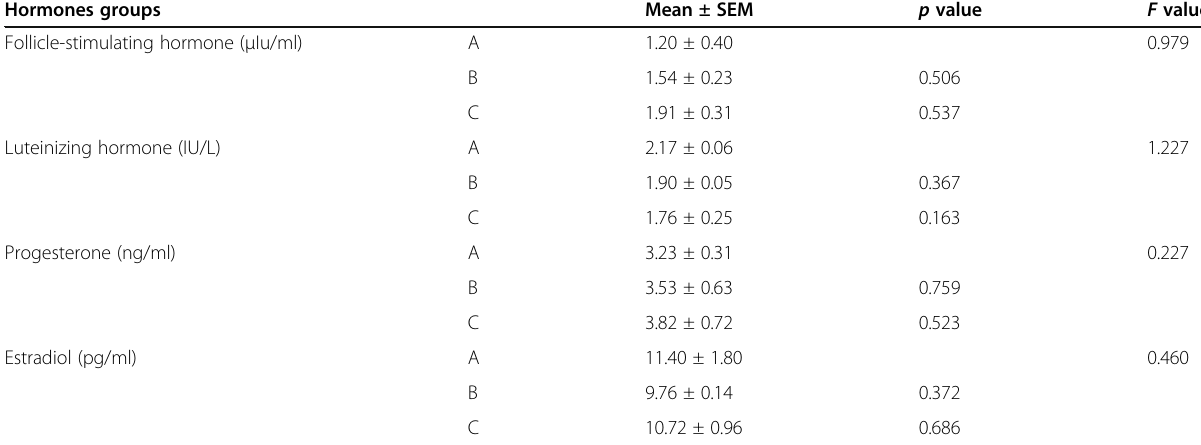
Table 3 The effect of MEPO on serum FSH, LH, progesterone, and estradiol levels of adult female Wistar rats Hormones groups